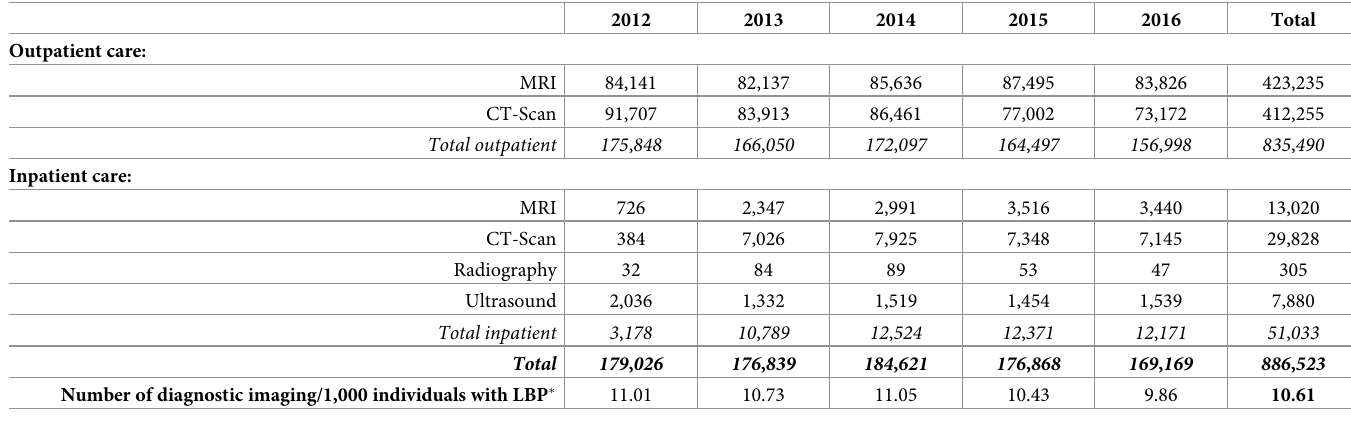
Table 2. Diagnostic imaging use during inpatient and outpatient care of individuals with Low Back Pain (LBP) in Brazil